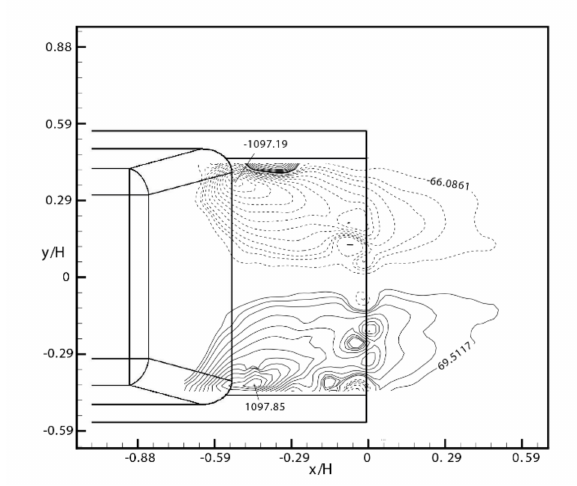
Figure 25. Iso-contours of time-averaged streamwise vorticity, ω z in the x–y plane at z/H = 0.18. Min- imum and incremental values of vorticity are ω z,min = − 66.086 s − 1 , 69.512 s − 1 , and ∆ ω z = 79.165 s − 1 , respectively.